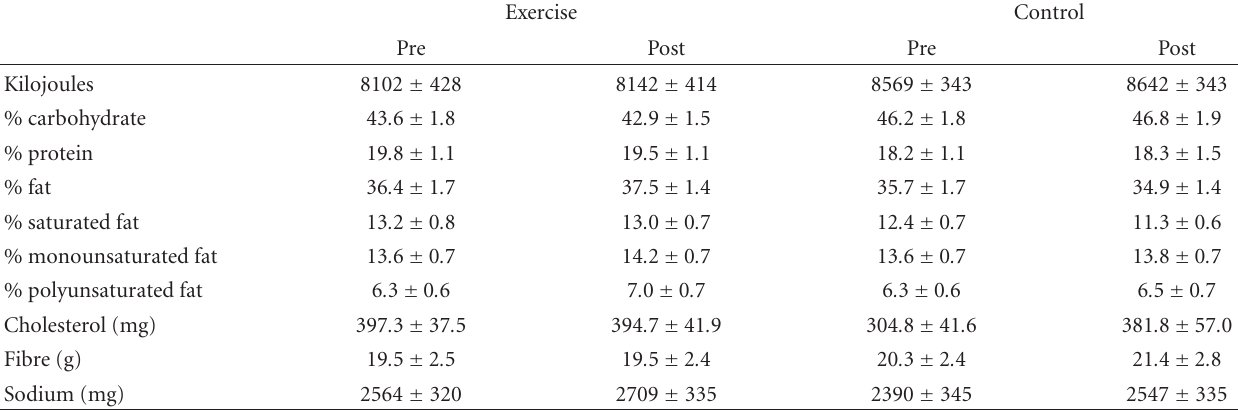
Table 5: Macronutrient levels before and after the 12-week-intervention ( N = 38; mean and standard error). Exercise Control Pre Post Pre Post Kilojoules 8102 ± 428 8142 ±